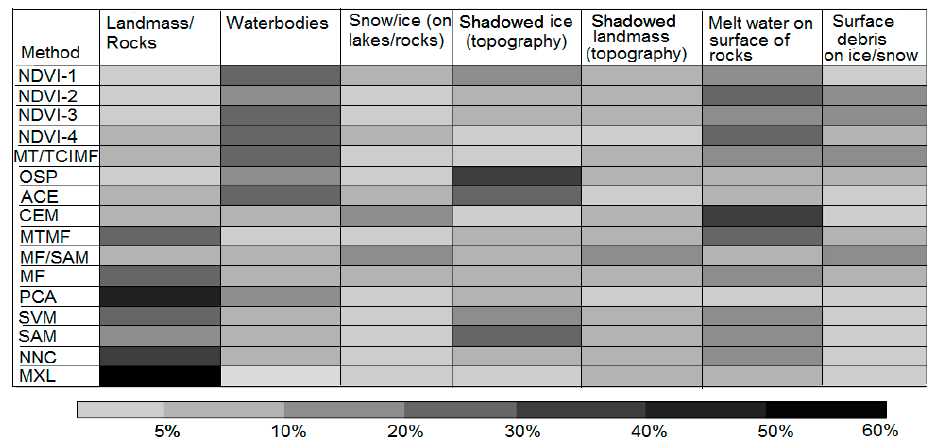
Figure 10. Misclassification (%) in vegetation mapping due to confounding spectral signatures of surrounding features and / or topography in the study area. The figure was prepared by using repeat observations of output vegetation maps derived by using 16 semiautomatic methods on the PAN-sharpened WorldView-2 (WV-2) satellite imagery and / or manually digitized vegetation map supplemented by ground truth map.